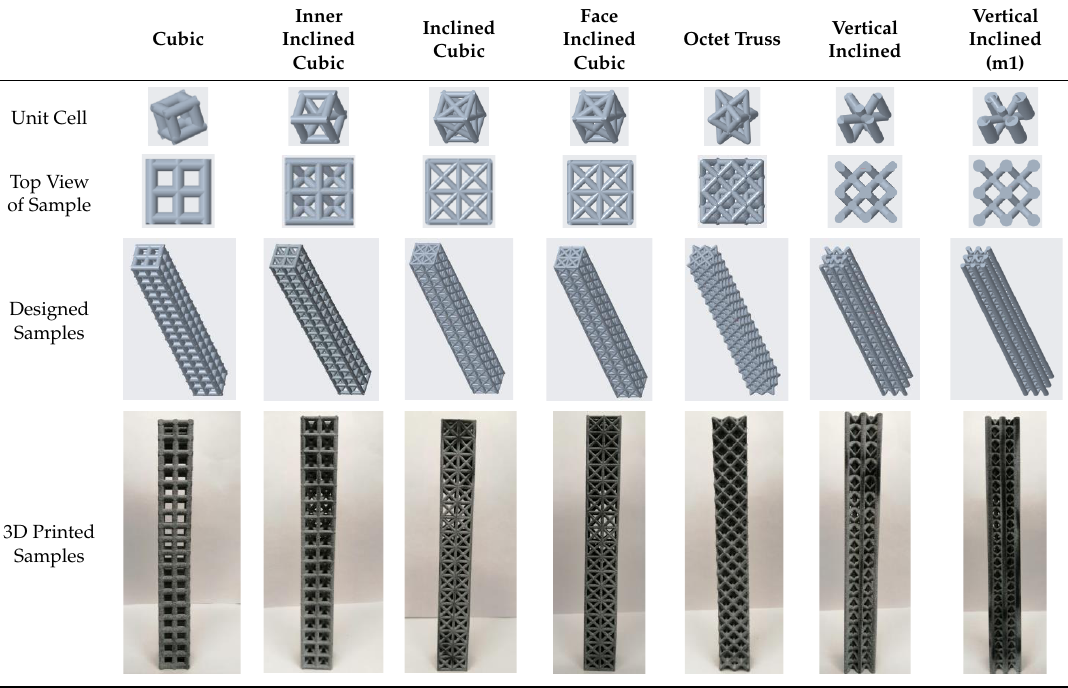
Table 1. Di ff erent types of cellular morphologies investigated in this study. Table 1. Different types of cellular morphologies investigated in this study. Table 1. Different types of cellular morphologies investigated in this study. Table 1. Different types of cellular morphologies investigated in this study. Table 1. Different types of cellular morphologies investigated in this study. Table 1. Different types of cellular morphologies investigated in this study. Table 1. Different types of cellular morphologies investigated in this study. Table 1. Different types of cellular morphologies investigated in this study. Table 1. Different types of cellular morphologies investigated in this study. Table 1. Different types of cellular morphologies investigated in this study. Table 1. Different types of cellular morphologies investigated in this study. Table 1. Different types of cellular morphologies investigated in this study. Table 1. Different types of cellular morphologies investigated in this study. Table 1. Different types of cellular morphologies investigated in this study. Table 1. Different types of cellular morphologies investigated in this study. Table 1. Different types of cellular morphologies investigated in this study. Table 1. Different types of cellular morphologies investigated in this study. Table 1. Different types of cellular morphologies investigated in this study. Table 1. Different types of cellular morphologies investigated in this study. Table 1. Different types of cellular morphologies investigated in this study. Table 1. Different types of cellular morphologies investigated in this study. Table 1. Different types of cellular morphologies investigated in this study.